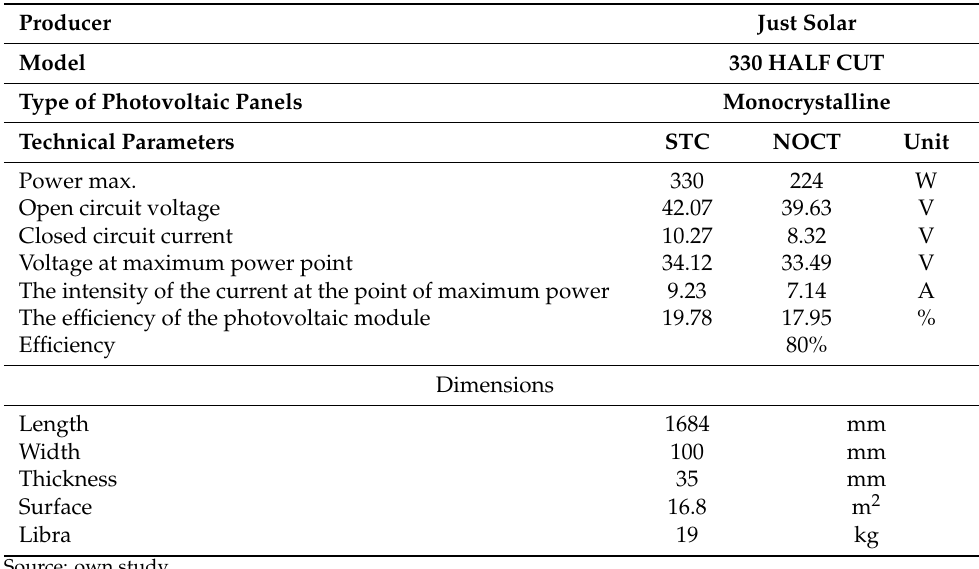
Table 1. Technical data of the Just solar module.